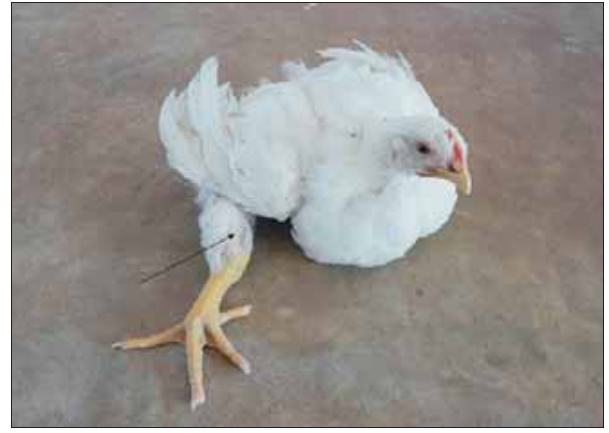
Figure-1: Slipped tendon causing leg weakness in high energy fed birds.